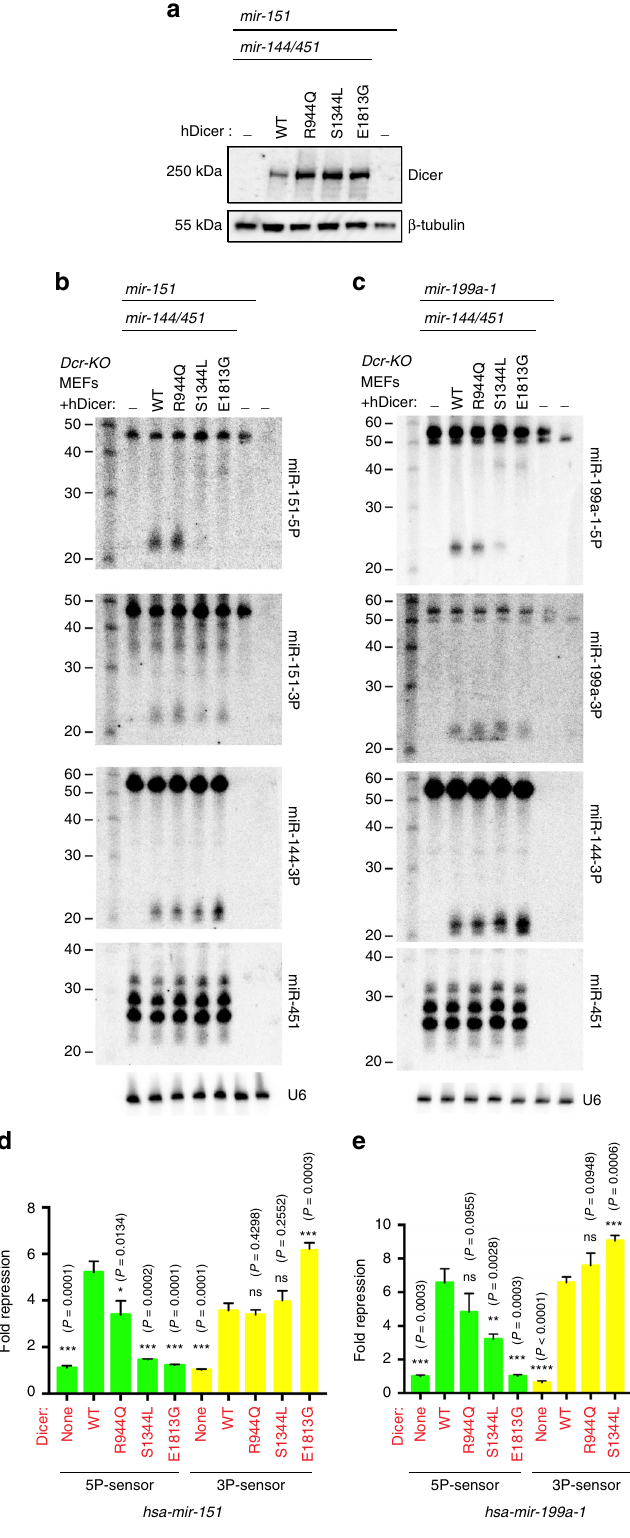
1-5p was slightly matured by S1344L compared to E1813G (Fig. 4d) and correspondingly had measurable activity on its sensor in S1344L but not in E1813G cells (Fig. 4e). This is consistent with the globally lower miRNA-5p depletion